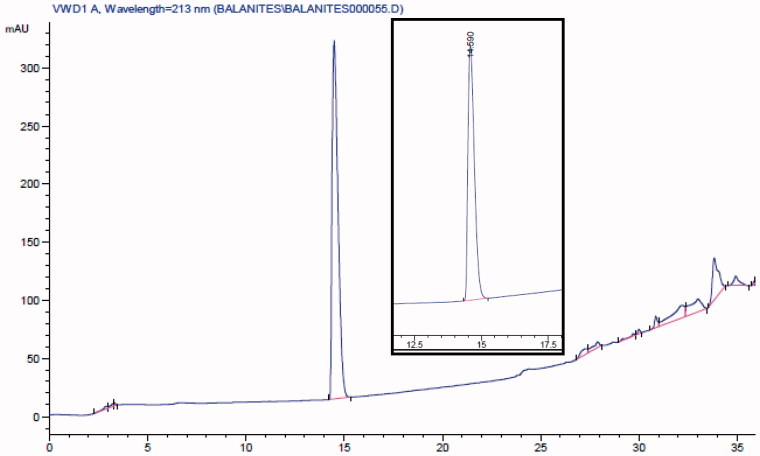
HPLC chromatogram of the 70% ethanol extract of B. aegyptiaca (BE) at 213 nm. The inset shows the standard stigmasterol-3 O-β-D-glucopyranoside at Rt = 14.6.min.